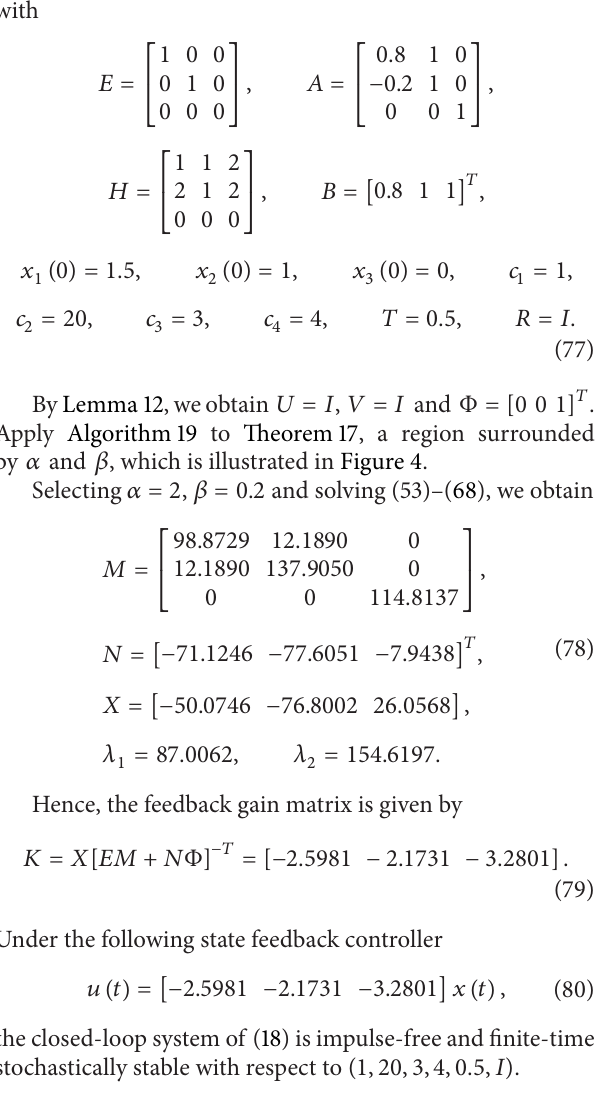
Example 2. Consider the Itˆo stochastic singular system (18)